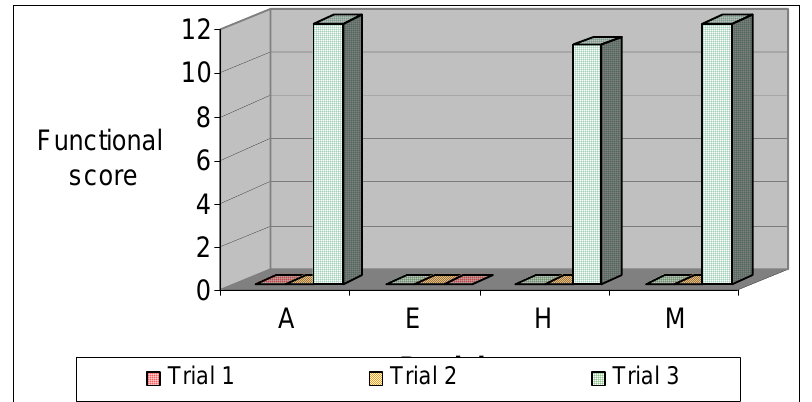
Graph 3. Change in stair-ascending ability tests 1–3, all participants.